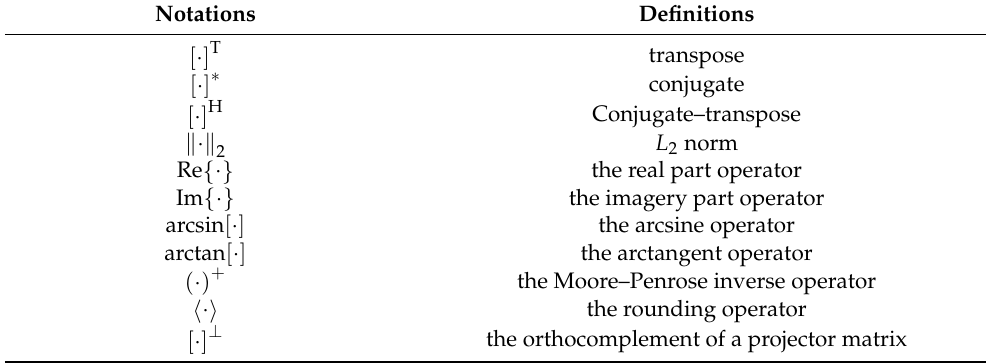
Table 1 defines the symbols in this paper. Table 1. Related